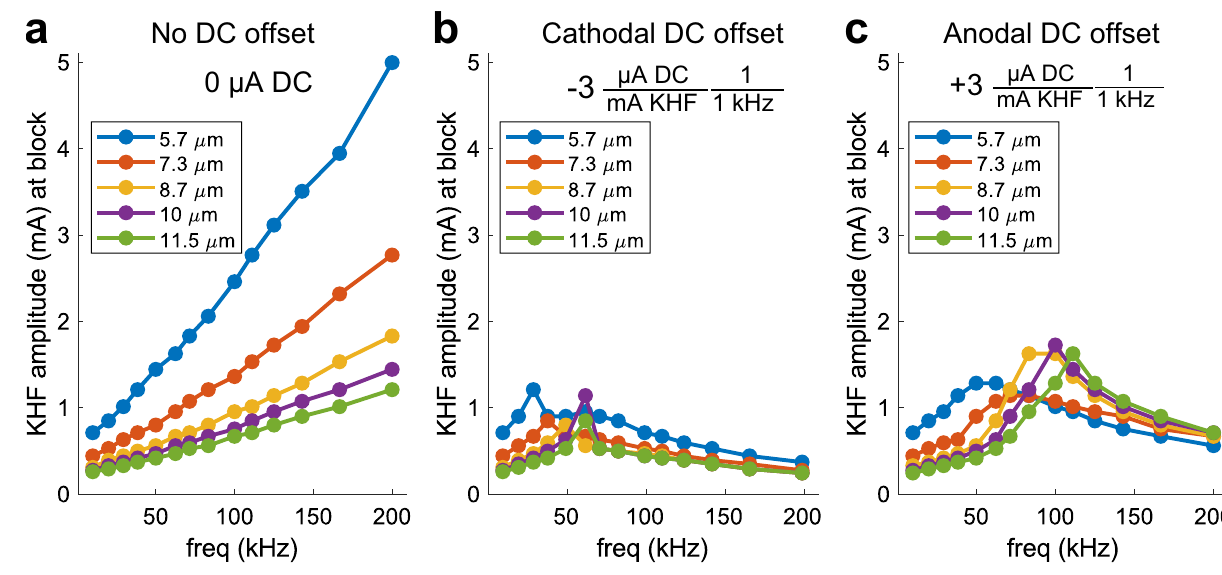
Figure 7. KHF block across modeled axons of multiple fiber diameters without ( a ) and with ( b , c ) amplitude- and frequency-dependent DC offsets. Each model axon was placed at the center of the rat tibial nerve FEM, and all axon lengths were 100